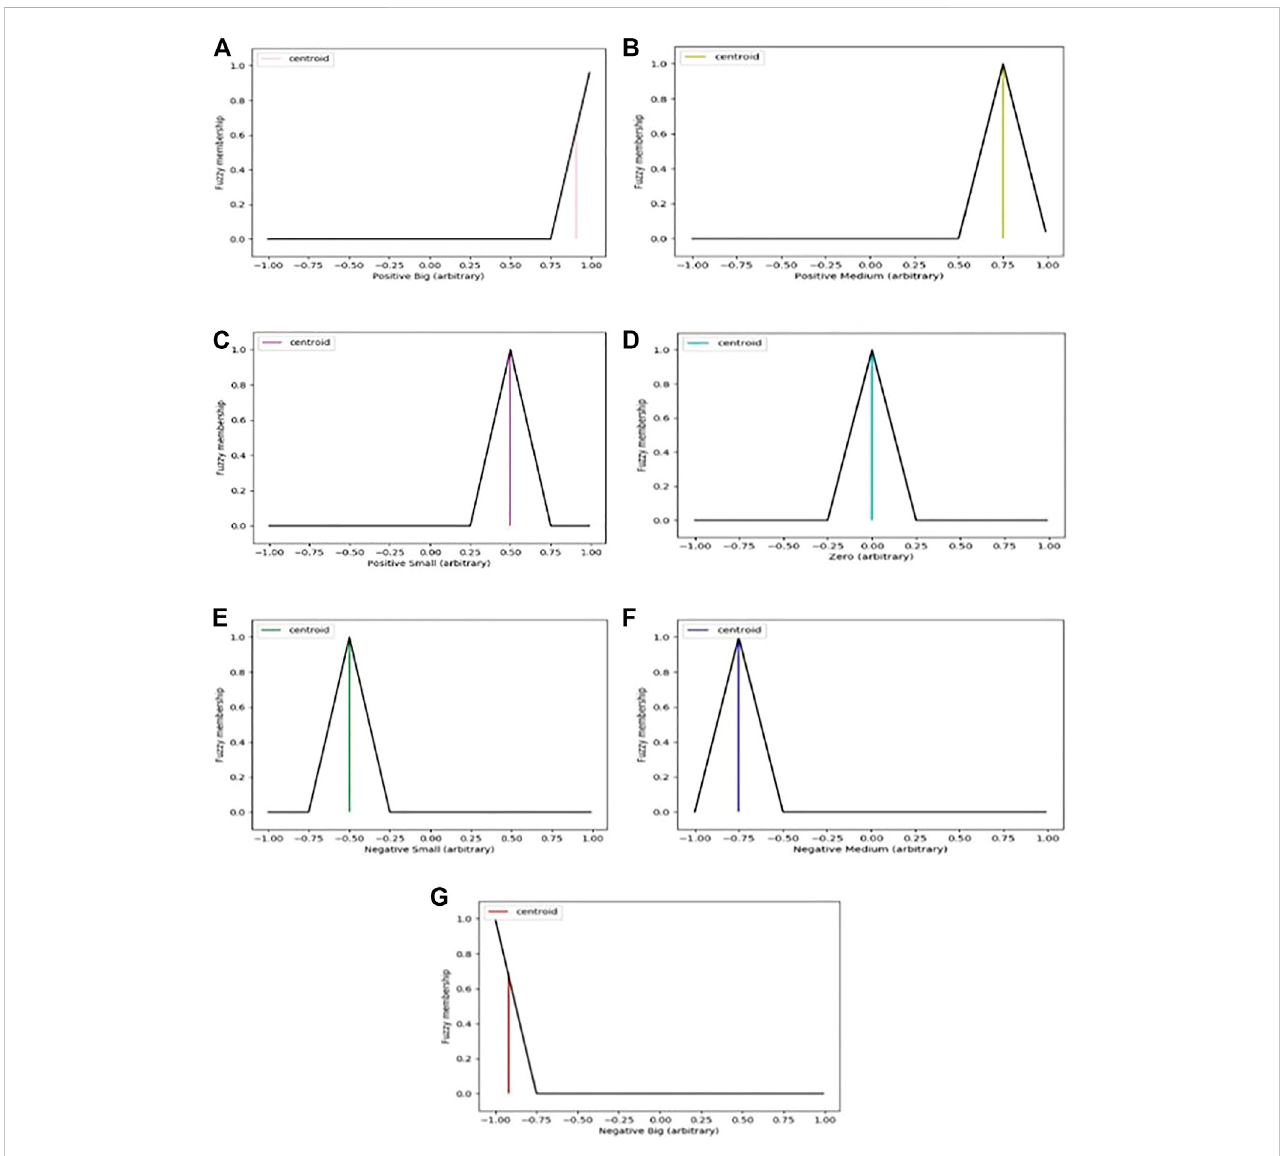
FIGURE 7 (A – G) : Arbitrary result for defuzzi fi cation using centroid